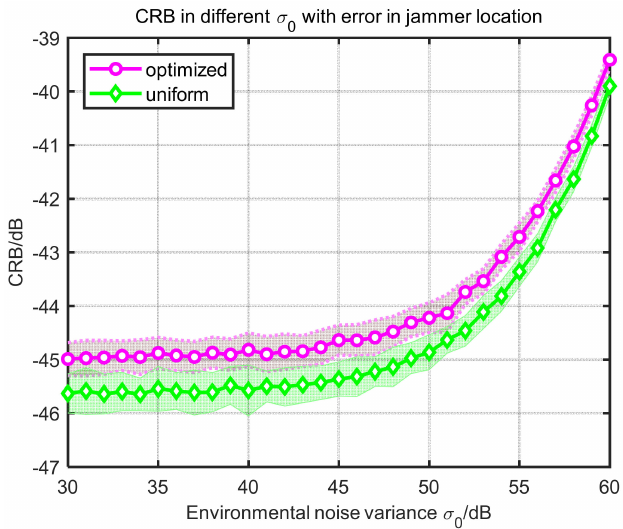
Figure 9. CRB under environmental noise with di ff erent